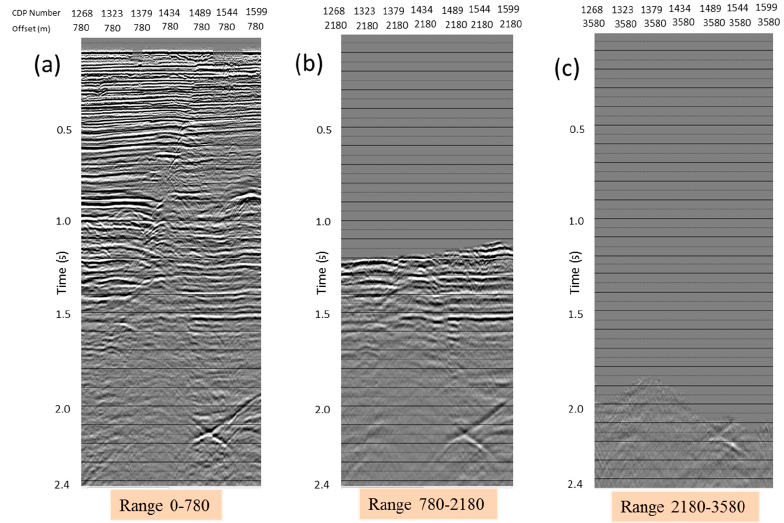
Figure 10. Multiple offsets gather data shows that shallow data is not recorded in the far offset. (a) range limited stack of 0–780 m, (b) 780–2180 m, and (c) 2180–3580 m.